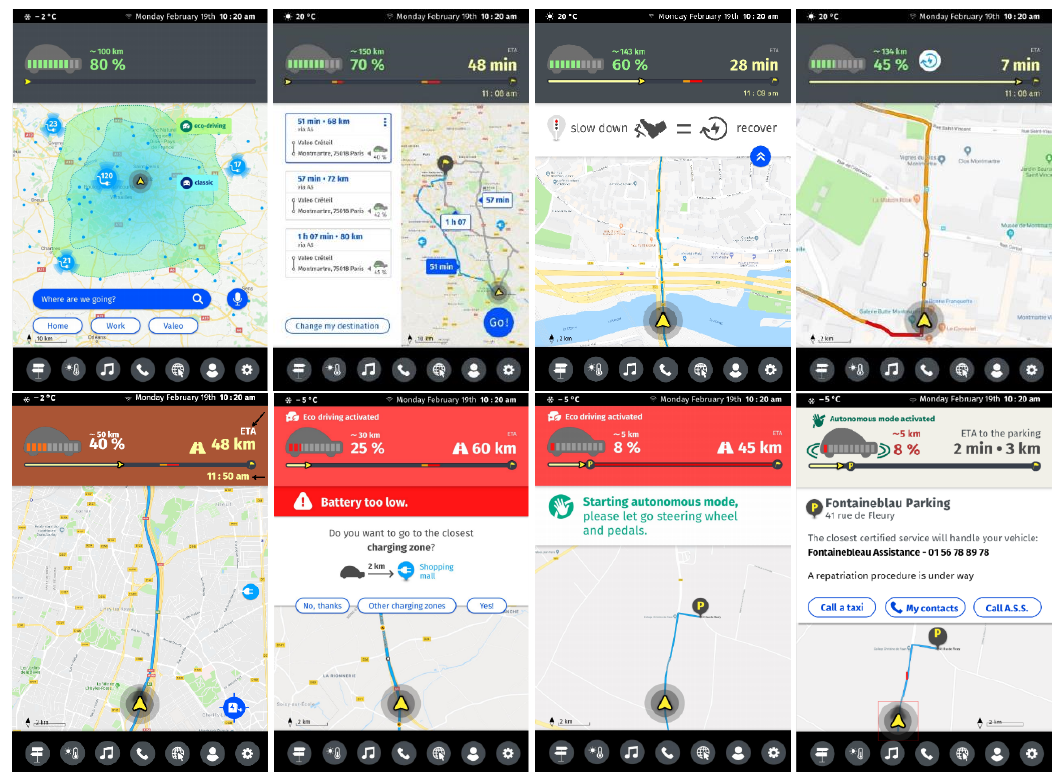
Figure 3. (left to right on upper line) (i) Isochrone maps that were reachable by using either normal driving or by activating eco-driving mode. (ii) The multiple paths leading to the destination, with individual estimation of the battery level at arrival. (iii) Traffic light coping strategy pop-up. (iv) Regenerative breaking indicator pop-up (left to right on lower line). (i) Icon to indicate the available charging stations. (ii) The Human–Machine Interface (HMI) proposed to go to the closest